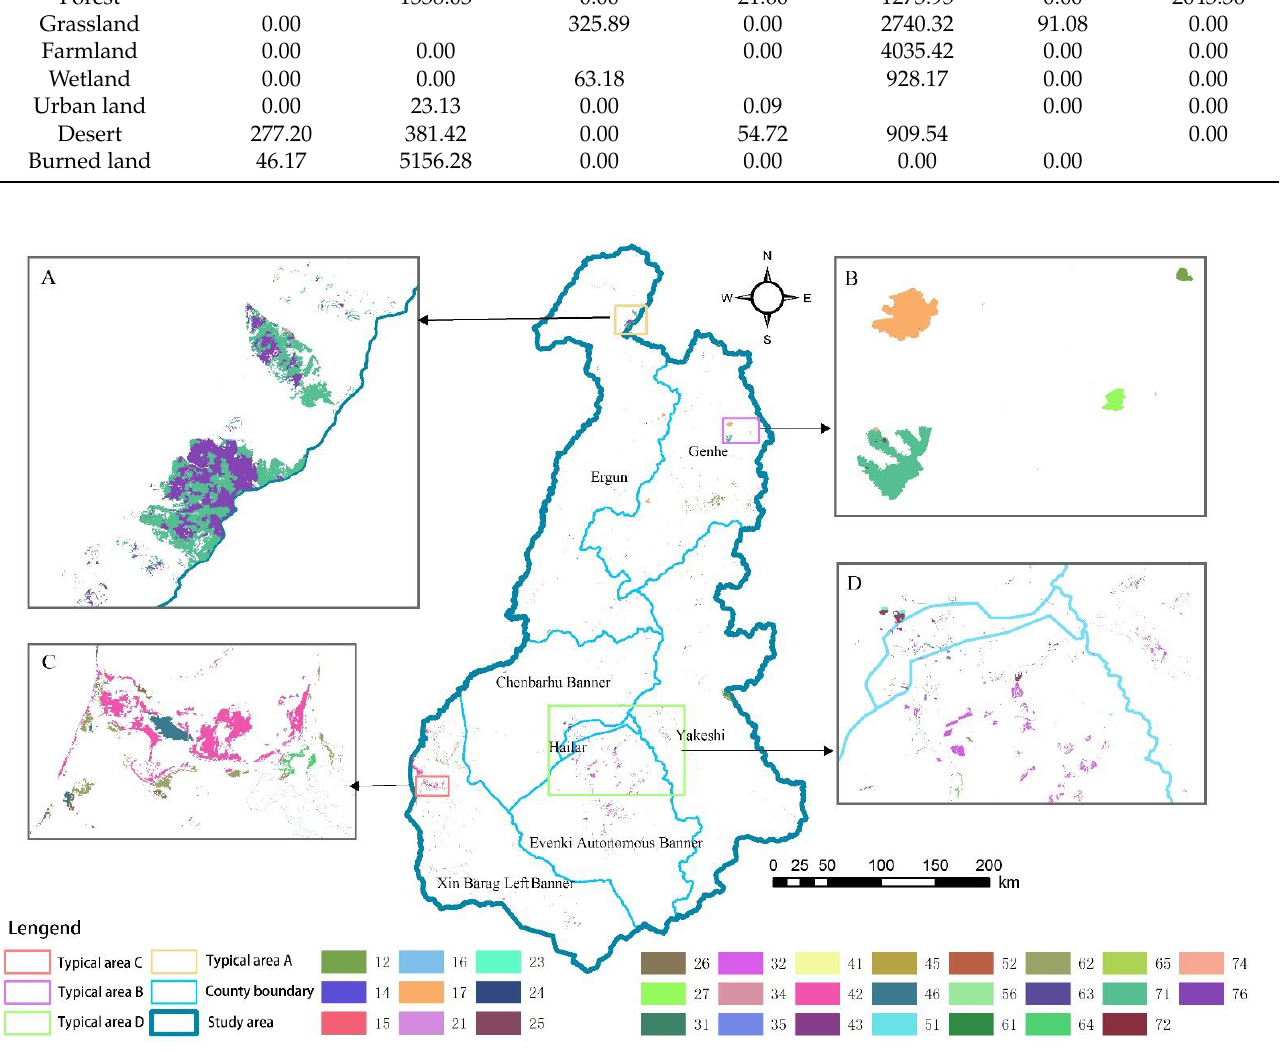
Figure 7. Land cover conversion map from 2000 to 2010: 1 represents forest; 2 represents grassland; 3 represents farmland; 4 represents wetland; 5 represents urban land; 6 represents desert; 7 represents burned land; 12 represents the change from forest to grassland; and 15 represents the change from forest to urban land.